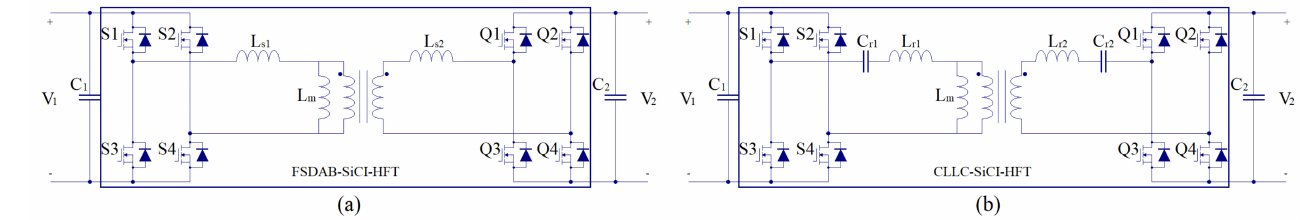
Figure 1. Unidirectional isolated DC–DC converters: ( a ) PSFB converter; ( b ) FB–LLC resonant converter. Figure 2a,b present a bidirectional PSFB DC–DC converter and a bidirectional FB- CLLC resonant converter, where four SiC MOSFETs are connected to both the primary and secondary sides of an HF transformer to form a symmetrical structure in each type transformer. In these integrated structures, the leakage inductance of the HF transformer can be used as the series inductance for the bidirectional PSFB DC–DC converter and as the resonant inductance for the bidirectional FB–CLLC resonant converter. Thus, two resonant capacitors used for the CLLC resonant tank will be treated as external components in an I-SiC-HFT.